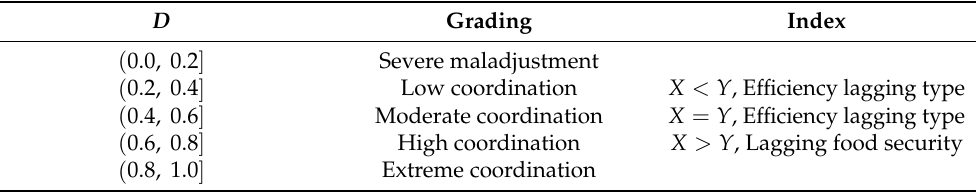
Table 2. Coupling coordination degree grading